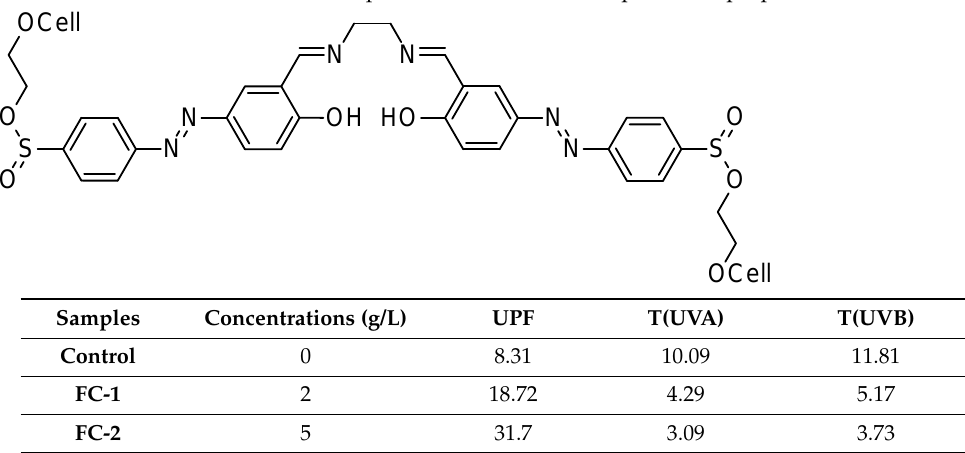
Table 1. Azobenzenic Schiff bases coupled on cellulose and UV protective properties.